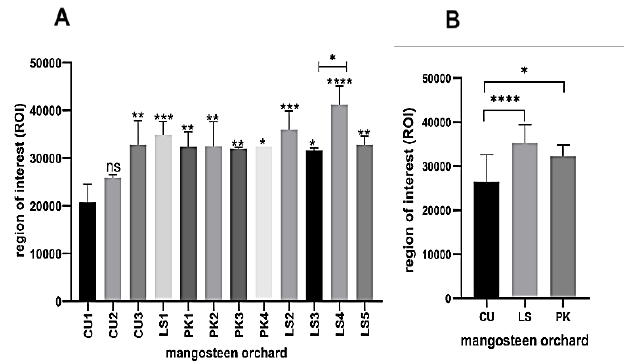
Figure 8: The alpha-mangostin labeling region of interest (ROI) intensity area of the mangosteen pericarp extract. (A) bar graph represents the mean content of the ROI of 12 mangosteen orchards. (B) bar graph represents the mean content of ROI of the orchards from three districts. The ns = p  0.05, *= p  0.05, ** = p  0.025, *** p  0.001, **** p 